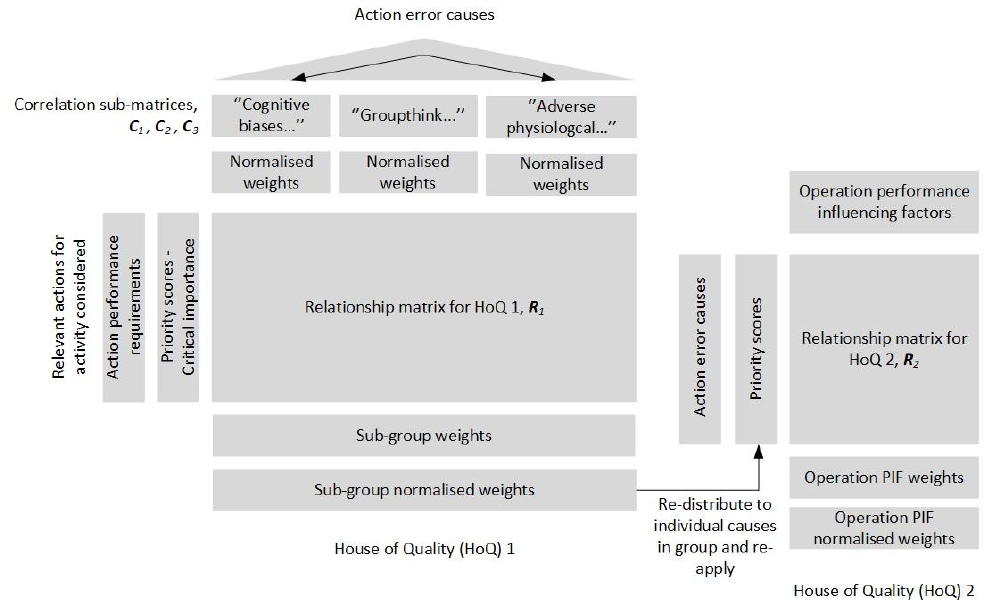
Figure 6. Quality function deployment for systematic evaluation of performance requirements between action and operation levels in task analysis using two quality houses.